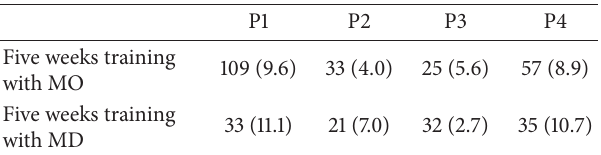
Table 4: The number of training days and average training hours/day (digits in the parenthesis) for each P at two-training